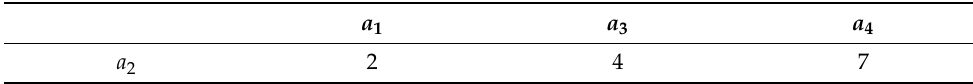
Table 5. Importance ratios of other attributes to a